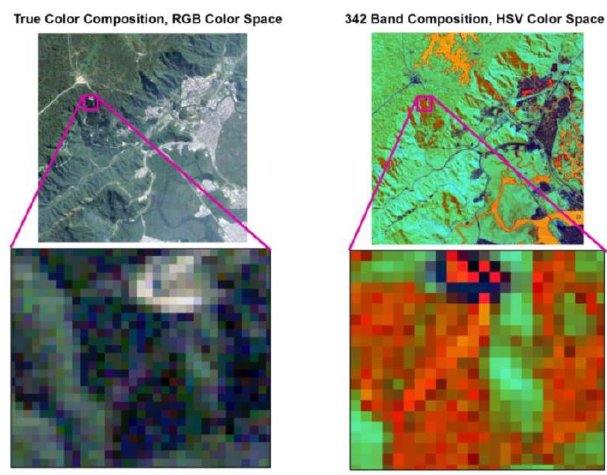
Figure 3. Sample of the LANDSAT 219-077 scene (25 June 2000) displayed in the RGB and HSV color space. To proceed with the classification, training areas were defined based on the user’s previous knowledge about the area, especially of the area of the known landslide at the Pilões watershed, using